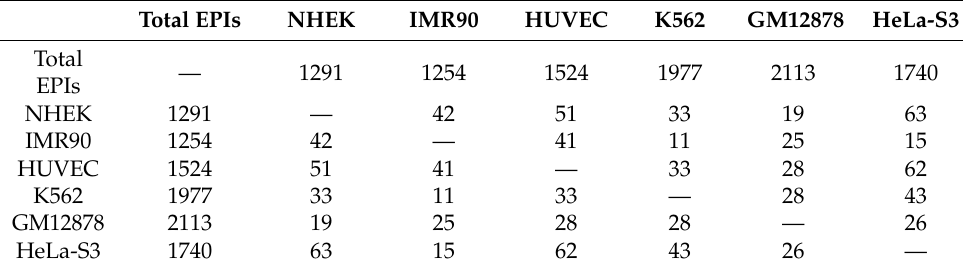
Table 6. The analyses of EPIs overlap ratio for different cell lines (100%).